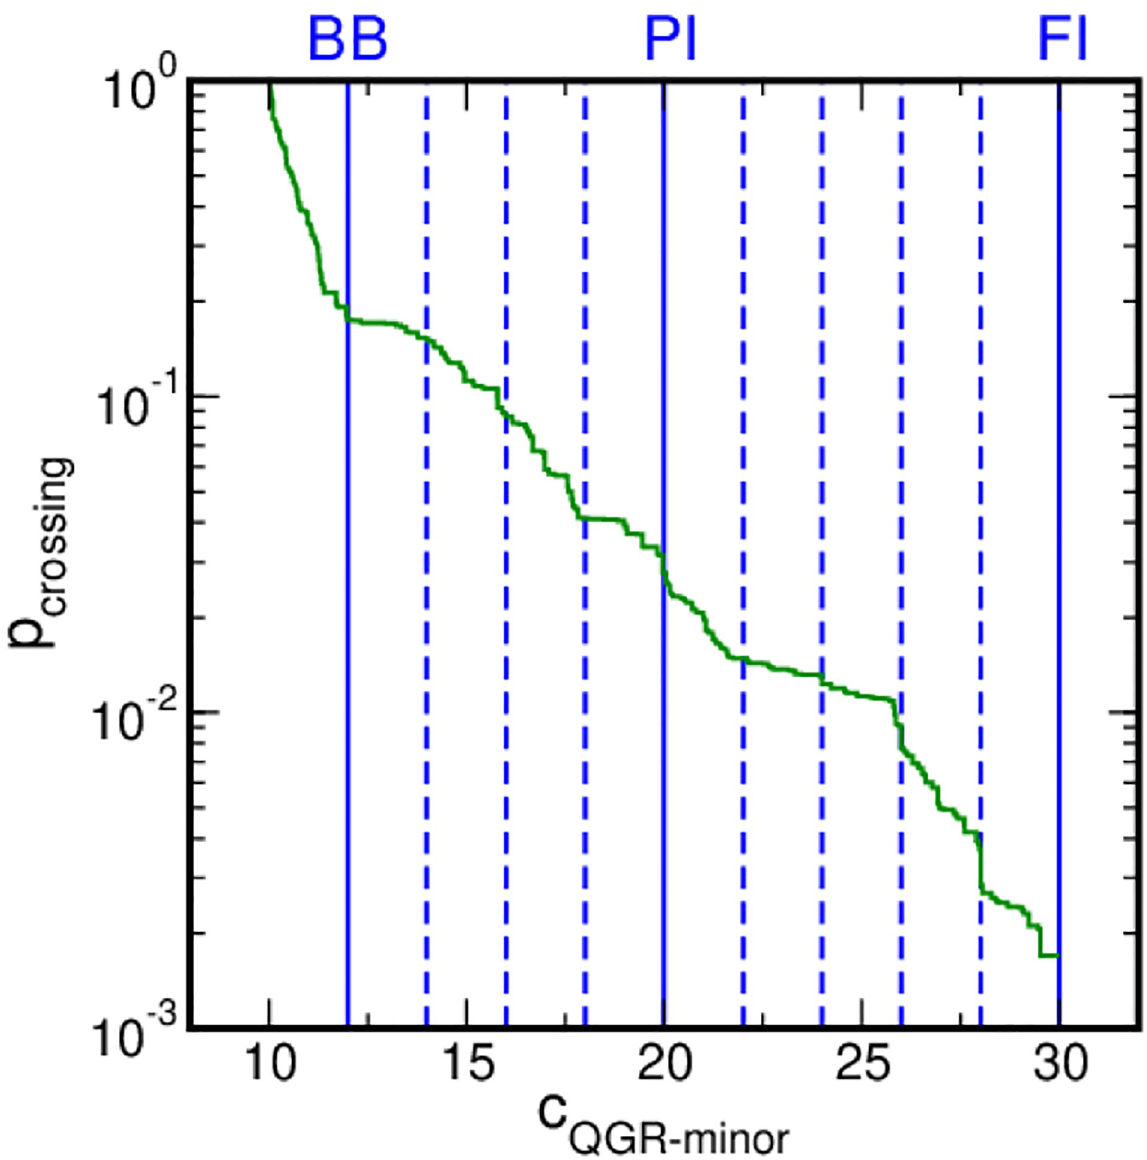
Fig 6. Crossing probabilities in the RETIS simulations. The crossing probability is shown as a function of c QGR − minor in green. The profile quantifies the probability for a path starting from the BB state to reach a certain c interfaces. The solid lines indicate the location of the stable